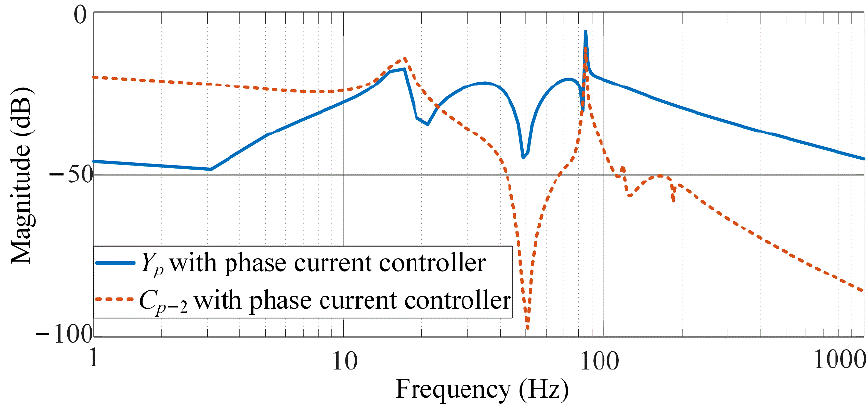
Figure 11. Bode diagrams of MMC admittance with the phase current controller. With the iteration shown in Figure 10, the condition for considering the coupling is obtained as 1.9 < SCR < 2.6. Figure 12 shows the Nyquist plot of Z g ( s ) Y MMC ( s ) considering or ignoring the frequency coupling, where only the dominant eigenvalue ( λ 1 ) is shown for simplicity. It can be seen when the coupling is considered, the Nyquist plot encircles the point ( − 1, j0) under SCR < 2.6, meaning that the system is unstable if SCR < 2.6. However, the Nyquist plot ignoring the coupling does not encircle the point ( − 1, j0) until SCR is less than 1.9, indicating the system is predicted to be unstable when SCR < 1.9. Therefore, ignoring the coupling will lead to a wrong stability assessment if 1.9 < SCR < 2.6.